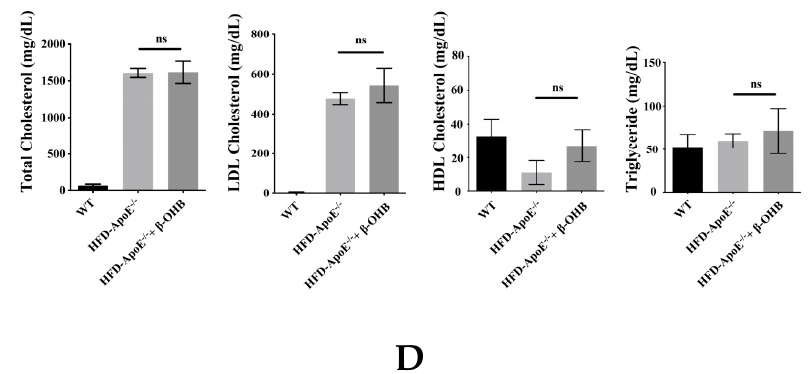
Figure 4. β -OHB attenuates atherosclerotic changes in ApoE -/- mice. ( A ) Oil red O staining of atherosclerotic plaques (arrowheads) in the aorta. Scale bars = 300 μ m. ( B ) Quantification of Oil red O stained area. ( C ) H&E staining of aortic roots. Scale bars = 200 μ m. ( D ) Serum lipid profiling. WT, normal chow diet-fed C57BL/6J; HFD-ApoE -/- , high fat diet-fed ApoE knock-out; β -OHB, β -hydroxybutyrate. *** p < 0.001.